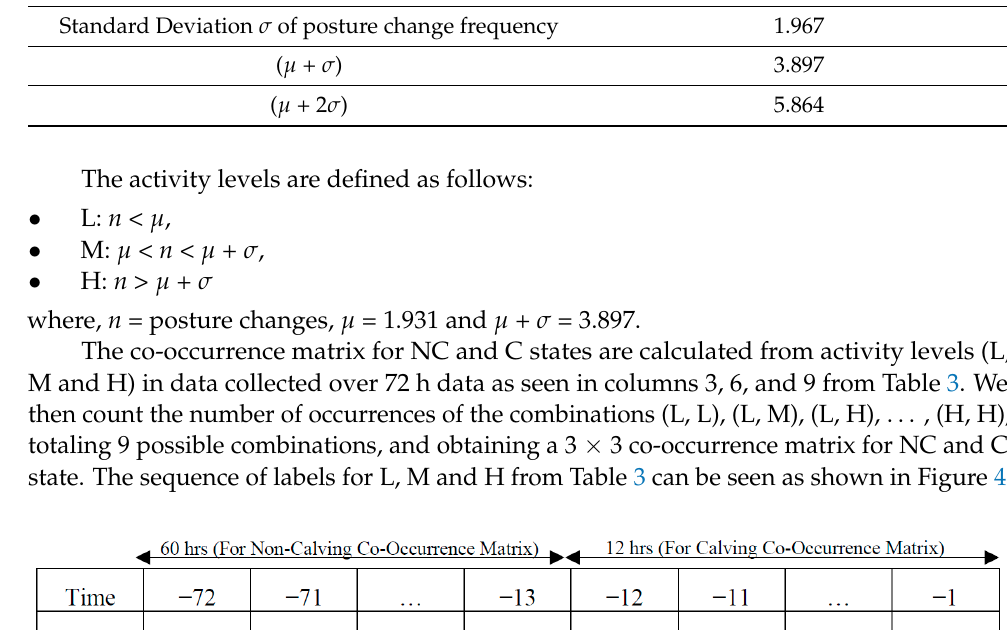
Table 4. Sample mean and standard deviation.